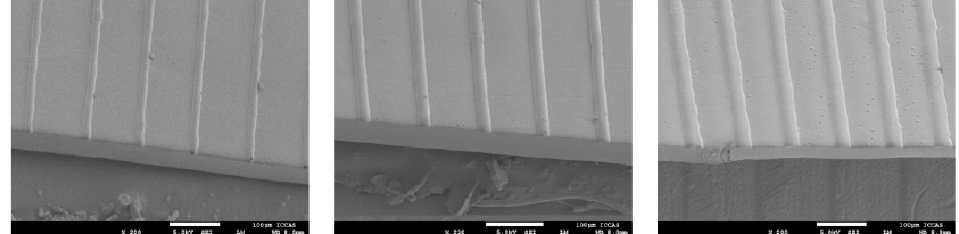
Figure 6. Morphologies of fabricated line microstructured surfaces of polyvinyl alcohol (PVA) based on etched line templates with different inkjet printing layers (1, 3, 5 layers from left to right).